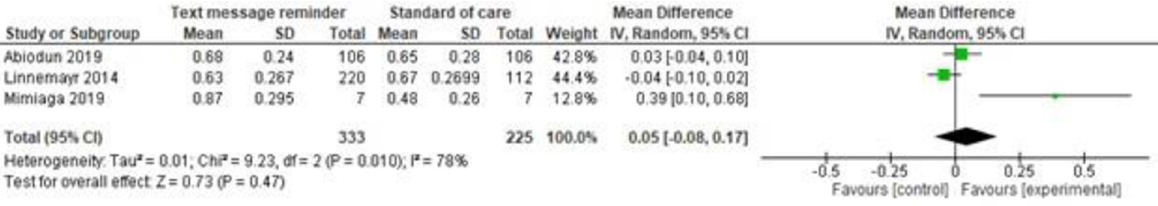
Fig 3. Forest plot of text message reminder versus standard of care for ART